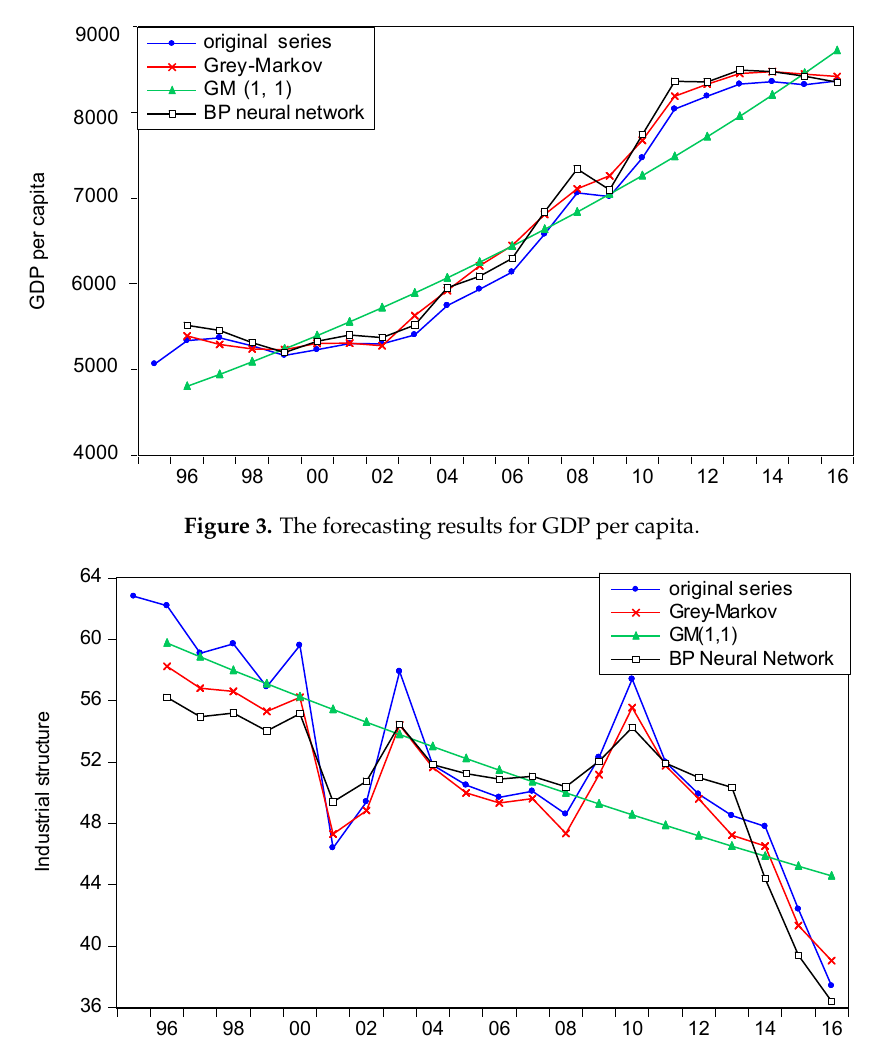
Figure 2. The forecasting results for population. Energies 2018 , 11 , x FOR PEER REVIEW